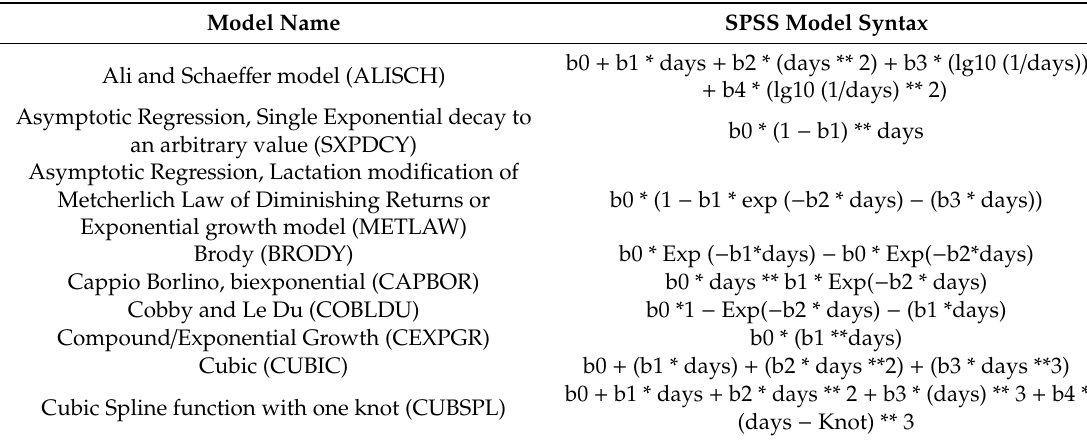
Table 1. SPSS models syntax for lactation curve in